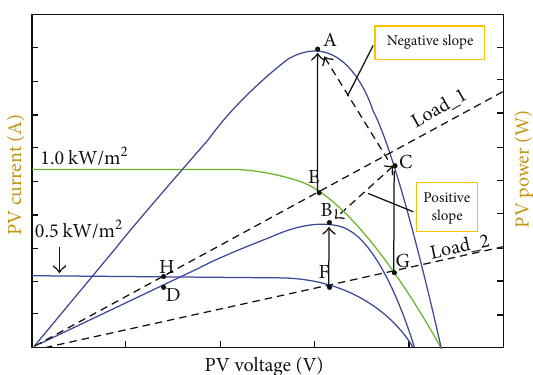
Figure 20: P ‐ V and I ‐ V curves for solar irradiation 500W/m 2 and 1000 W/m 2